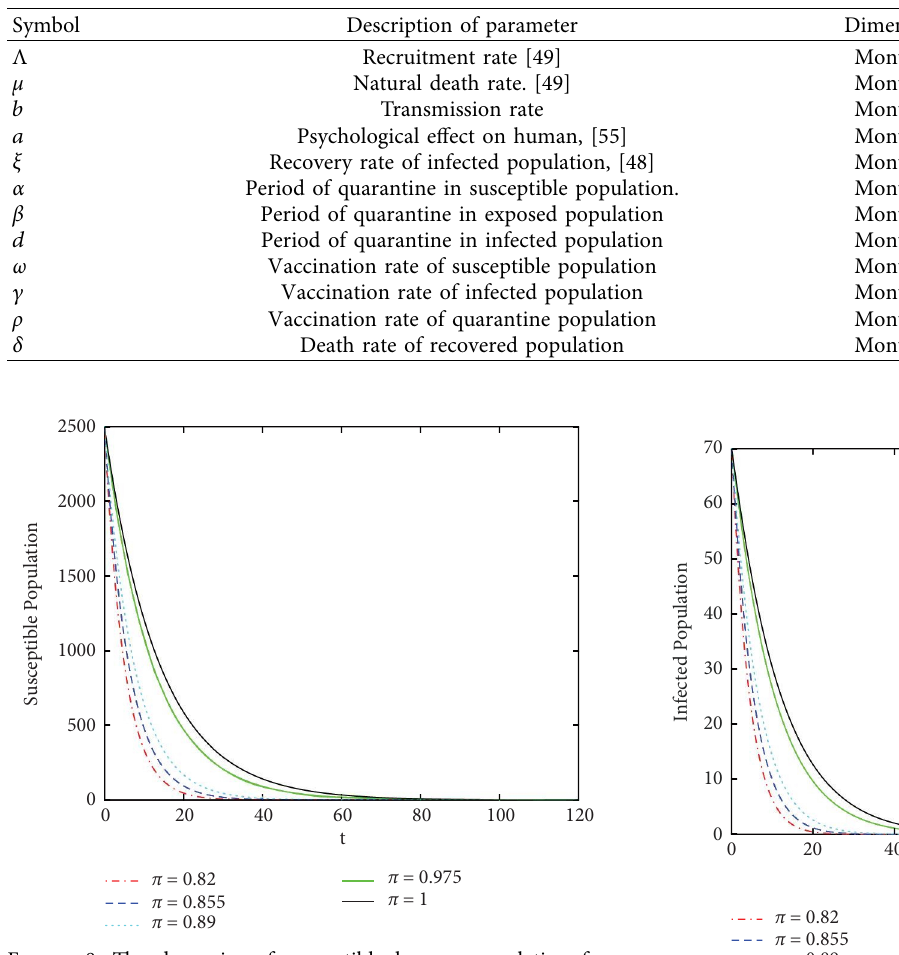
Figure 8: Te dynamics of susceptible human population for various fractional orders π and for fractal order υ � 0 . 5.